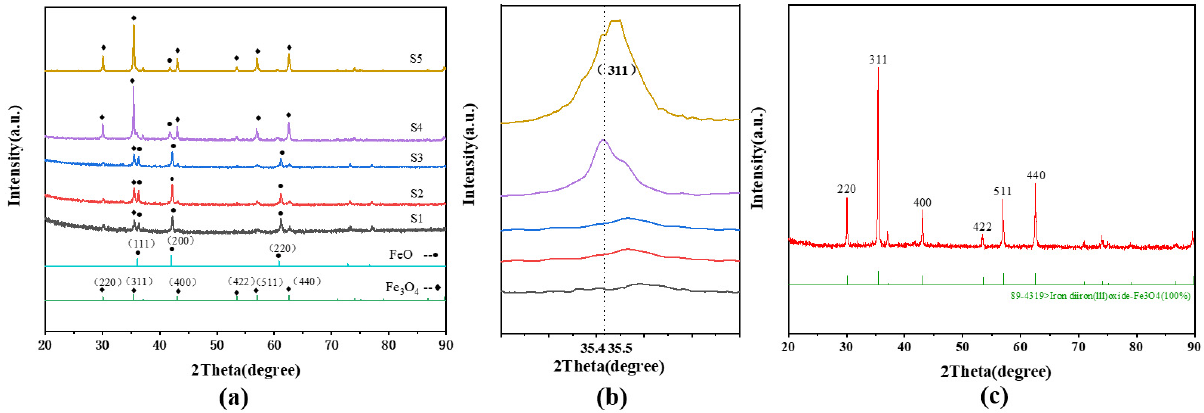
Figure 1. ( a ) XRD patterns of Fe 3 O 4 /FeO nanoparticles. ( b ) (311) diffraction peak of Fe 3 O 4 /FeO nanoparticles. ( c ) XRD pattern of Fe 3 O 4 NPs (S6).